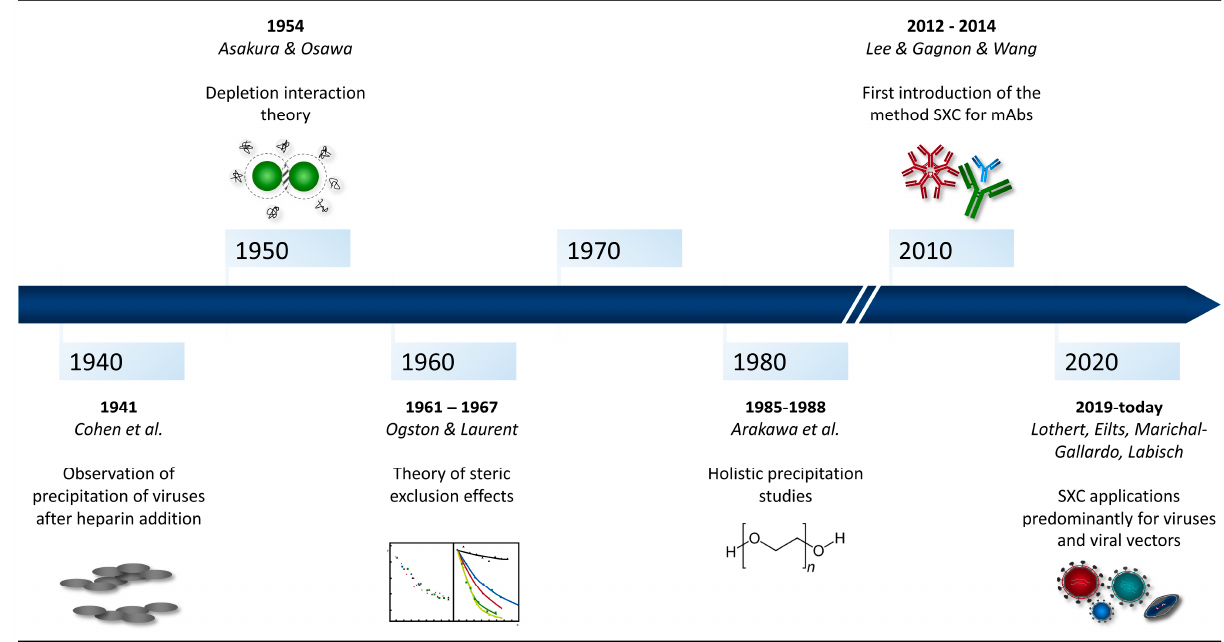
Figure 1. Timeline of the development of steric exclusion chromatography, starting from studies on theoretical principles to the first application and current applications of SXC.